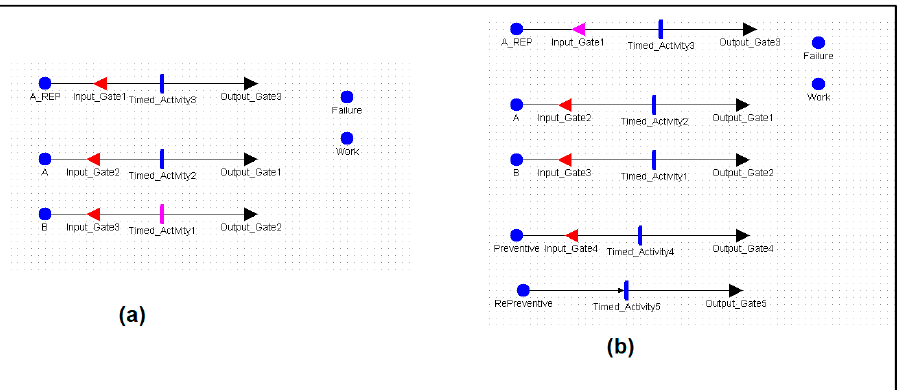
Figure 5. Stochastic Activity Network model of the AND Gate:( a ) with corrective maintenance (2C) and ( b ) with preventive maintenance (2P).